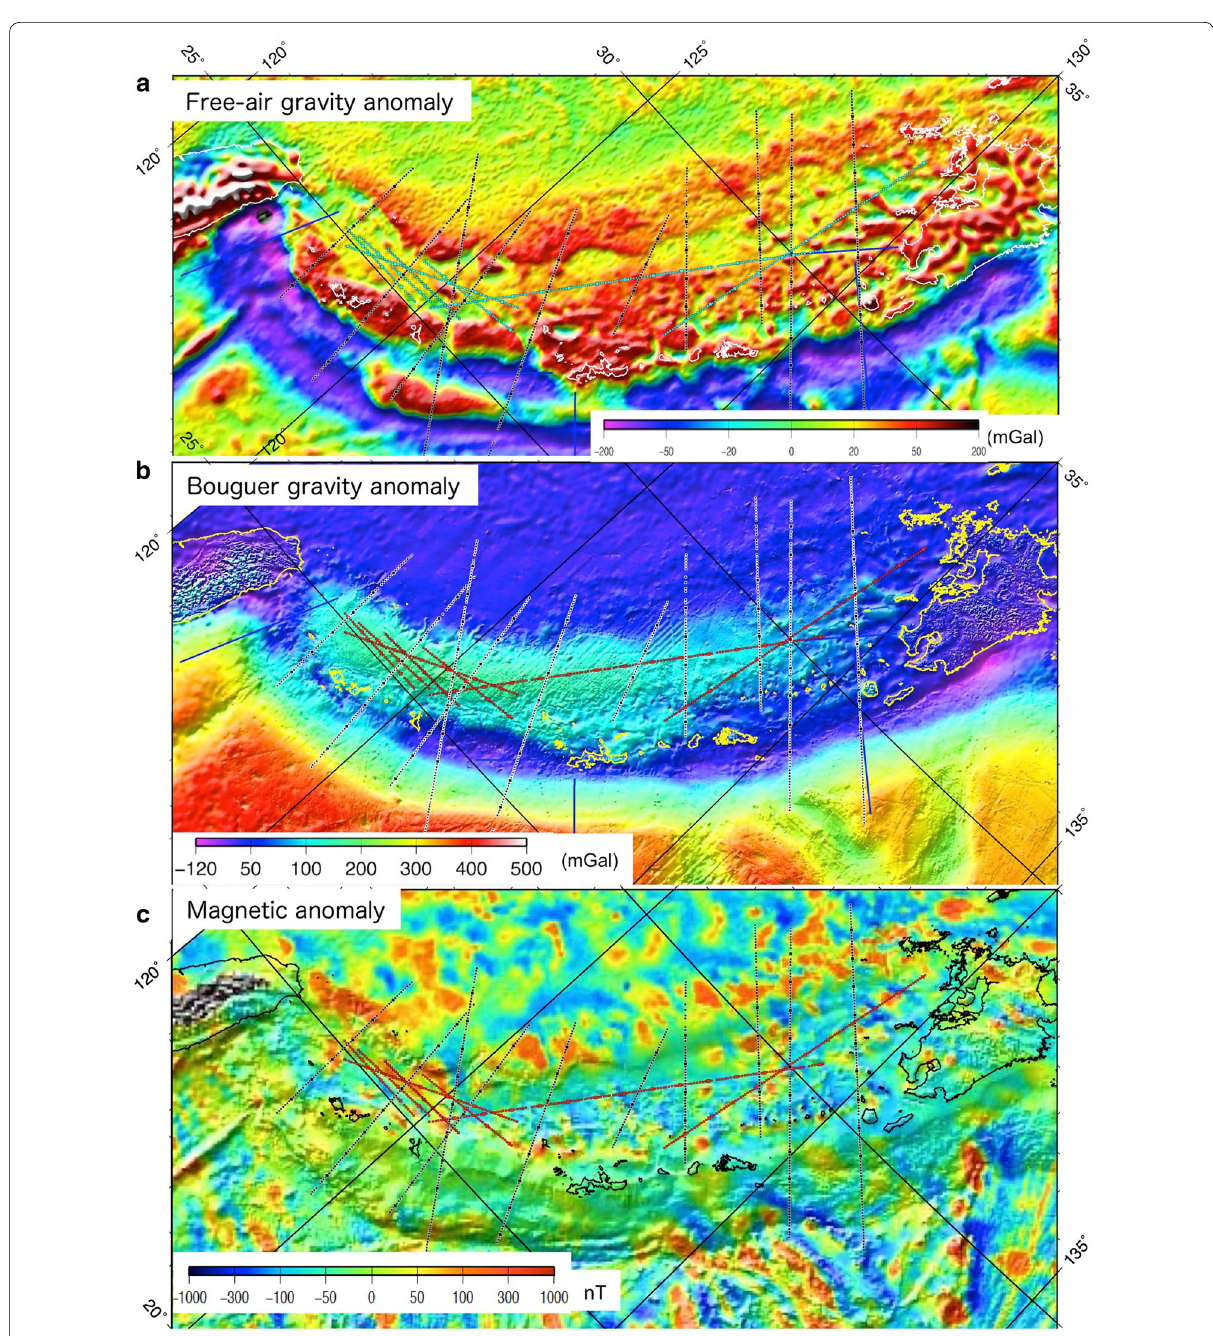
Fig. 3 Geophysical maps in and around the OT. a Free-air gravity anomaly map. b Bouguer gravity anomaly map. The Bouguer anomaly was calculated using an average crustal density of 2.67 10 3 kg/m 3 and corrected for a terrain effect within a radius of 30 km (Oikawa and Kaneda × 2007). c A magnetic anomaly on the shaded bathymetry. The magnetic anomaly map was produced by a combination of our original data, CCOP (http://www.ccop.or.th/), and EMAG2 (https ://doi.org/10.7289/v5mw2